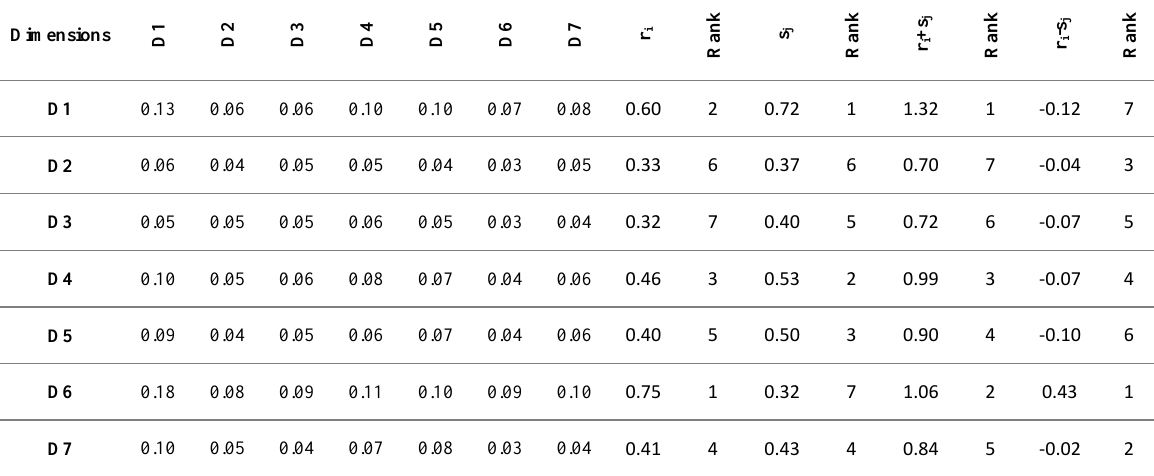
Table 11. Matrix T D (total influences of